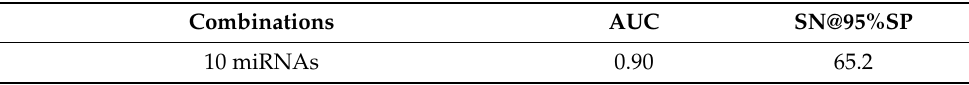
3.3. Free Circulating miRNA Levels in the Serum Have Lower Discriminating Potential In comparison to exo-miRNAs, none of the tested serum miRNAs distinguished CRC from healthy controls (all > 0.05). However, all serum miRNAs showed different median- normalized microRNA levels when adenomas and controls were compared (Supplemen- tary Table S6, details in Supplementary Table S7). Additionally, all but two free circulating miRNAs in serum (c-miR-19 and c-miR-222) revealed divergent median levels between the adenoma group and the CRC group. 3.4. Tumor Marker The median CEA level was 0.35 [range: 0–4.08] for healthy controls and 1.1 [range: 0– 3.4] for CRC patients. The median CA-19-9 level was 1.7 [range: 0–5.36] for healthy con- trols and 2.64 [range: 0–5.46] for CRC patients (Supplementary Table S8). While CEA was not able to discriminate between the study groups (all p > 0.05), CA 19-9 was able to dif- ferentiate significantly between healthy and CRC patients ( p = 0.041). 4. Discussion Various reports highlight the potential relevance of miRNAs for diagnosis and prog- nosis in CRC, although the results sometimes are contradictory [13–16]. Some major ad- vantages of using miRNAs as biomarkers are their stability against external influences such as pH-alteration, storage, freezing and thawing, as well as their complex involvement in multiple cellular mechanisms that regulate tumor growth and progression [50,51]. In recent years, many research groups tried to optimize the potential of miRNAs as cancer bi- omarkers. One concept prioritizes the assessment of miRNAs in exosomes as they are fre- quently released from cancer cells and may present a compartment for the enrichment of